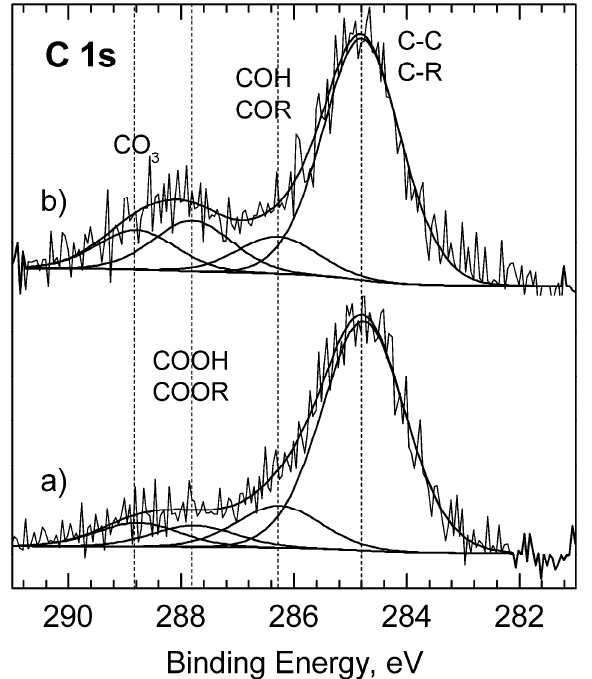
Figure 5. XPS C 1s spectra with deconvolution for Ni coatings: ( a ) “as-deposited”, ( b ) “as-deposited” and stored open to air for 24 h, analyzed in the “as-received” form. Table 2. Changes in chemical composition (at.%) of the outer surface of the as-deposited Ni coating and the Ni coatings after annealing for 2 h at: 100, 200, 300 and 400 °C. The surface of nickel coatings was analyzed immediately after deposition plus annealing and after a gentle/mild Ar + cleaning (1.5 keV, 2 μ A cm − 2 , 60 or 90 s).